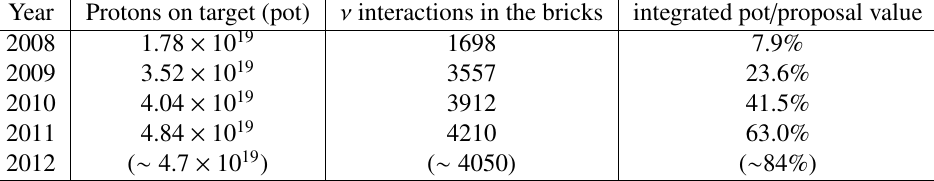
Table 1. CNGS performances and corresponding neutrino interactions in the OPERA detector: status